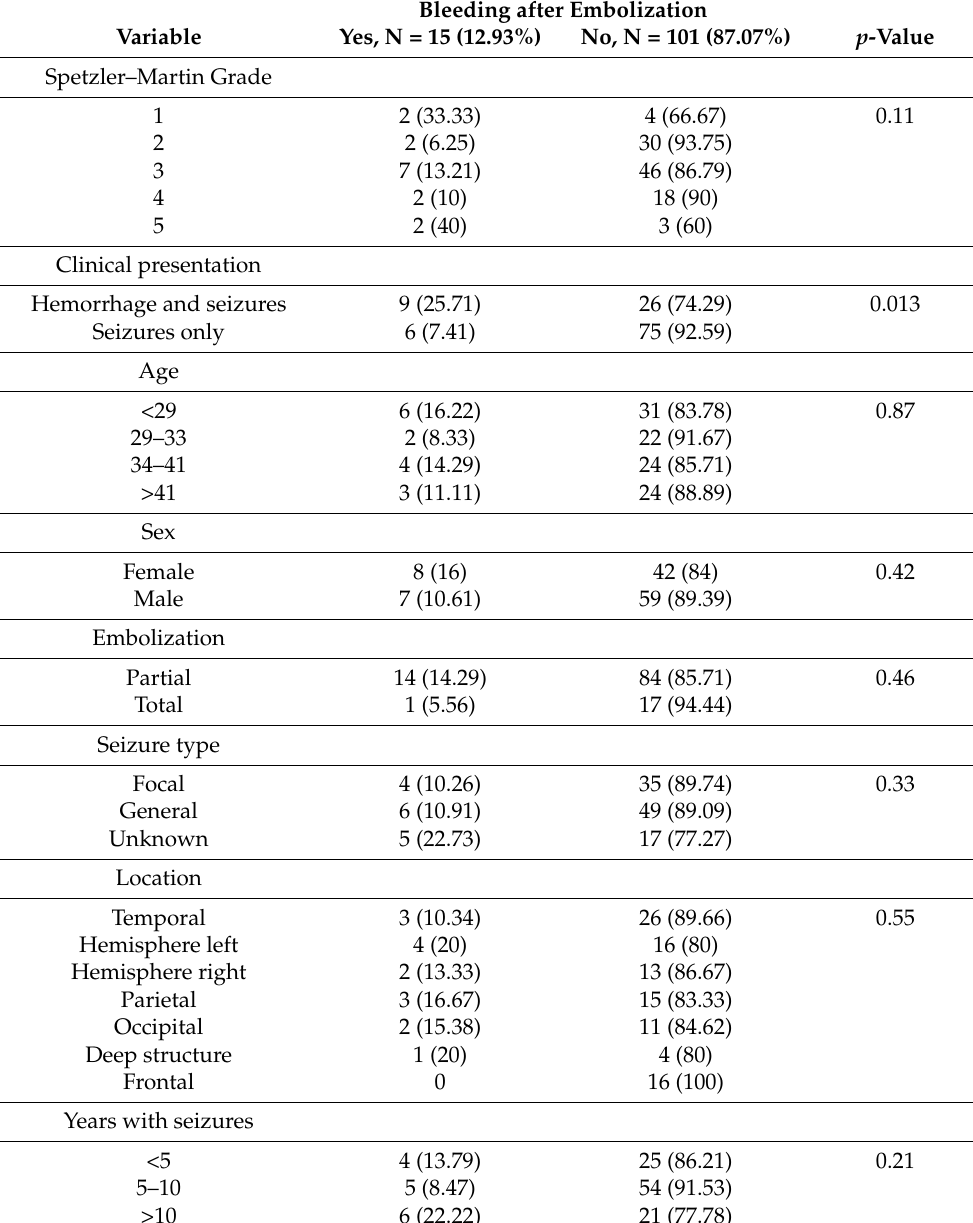
Table 3. Factors associated with bleeding after embolization.